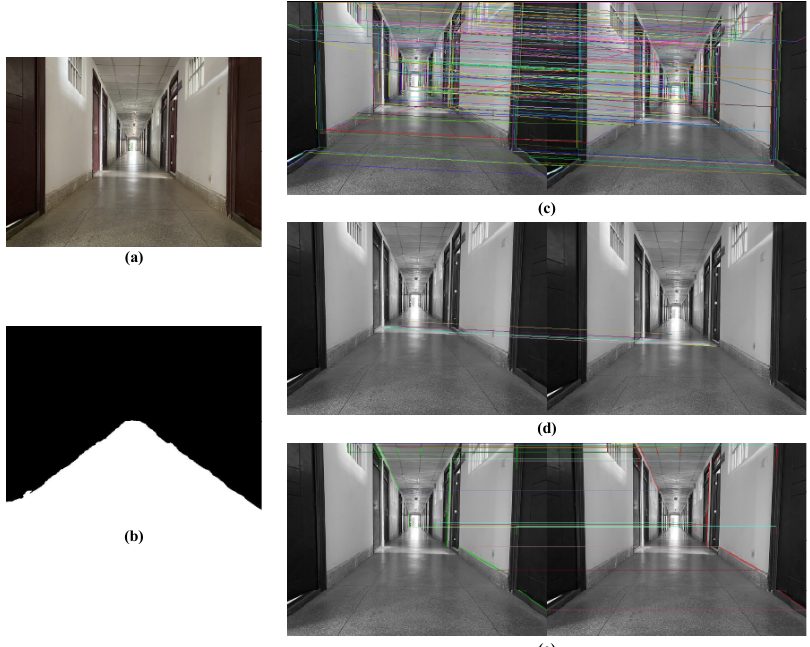
Figure 10. Fusion of semantic invariants for line segment matching. ( a ) The raw image; ( b ) the semantically segmented binary image; ( c ) the results of line segment matching by LBD descriptors in the OpenCV [40] library; ( d ) and ( e ) line segment matching results after adding semantic invariants. Table 1. Results of using different methods to associate the data of line segments.